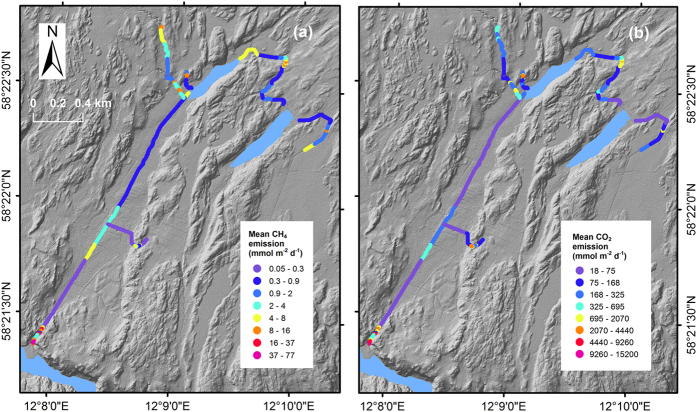
Mean modelled CH4 (a) and CO2 (b) emissions from the streams of SRC showing hotspots for emission. The majority of the streams had low emissions, but some reaches had high emissions due to high k or high concentrations or a combination of both. The figure was created with ArcMap 10.3.1 available from http://www.esri.com/. The background maps, obtained from Lantmäteriet (National Land Survey of Sweden), were published under the copyright agreement i2012/898 with Linköping University.